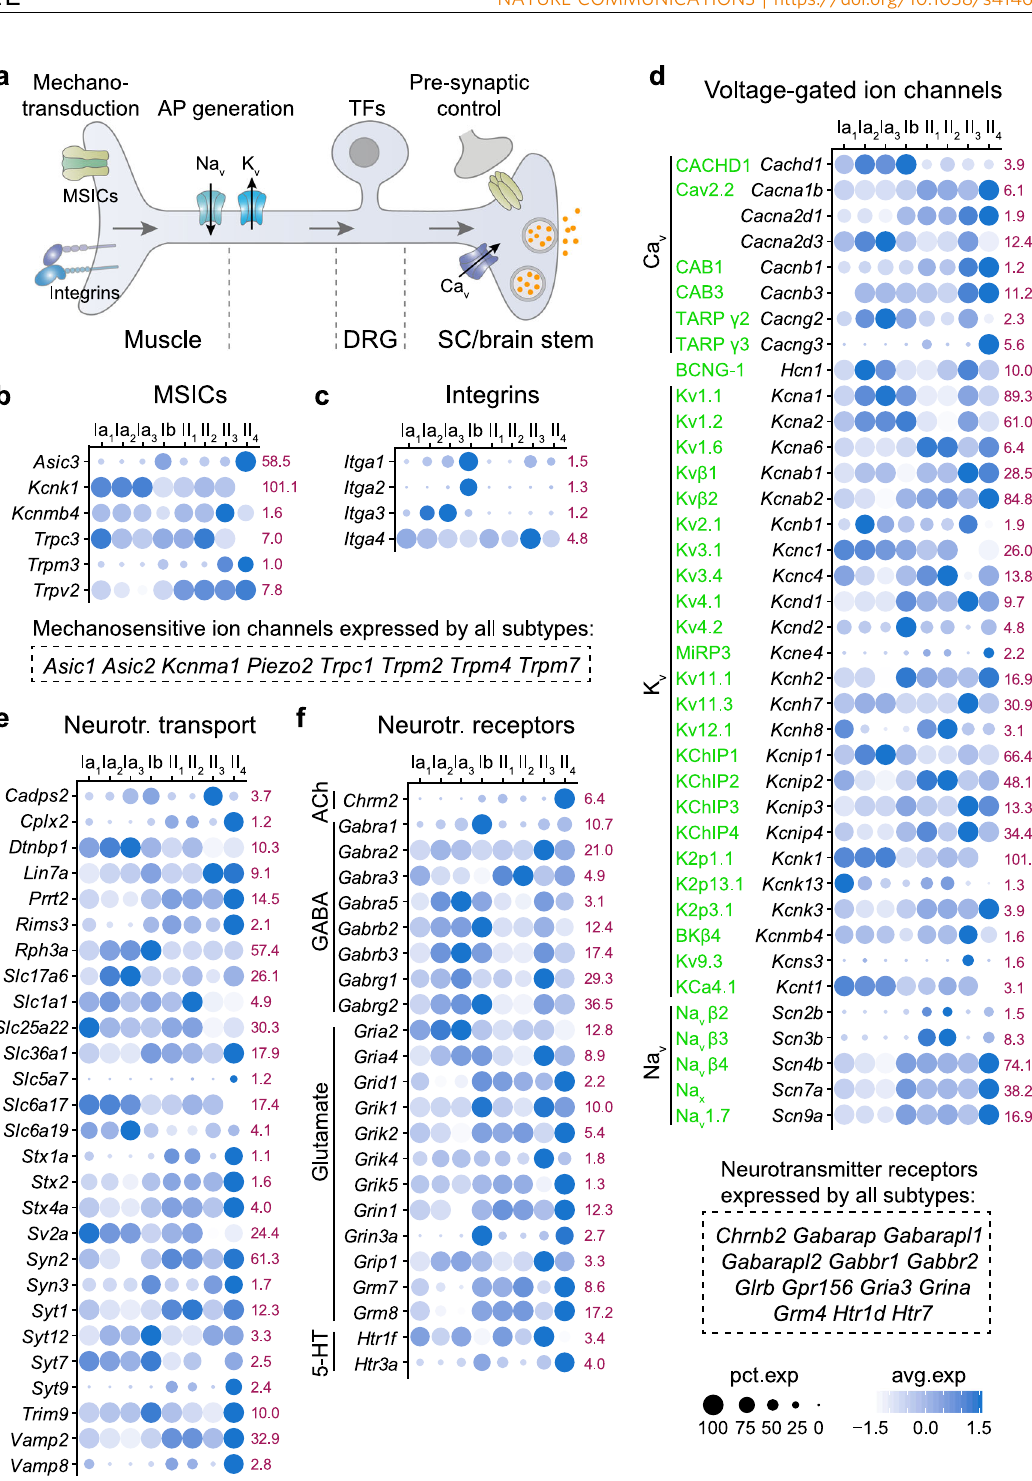
Fig. 4 Unique molecular signatures of neuronal communication pattern in the PN subtypes. a Schematic depicting gene categories important for intrinsic electrical properties and input-output communication patterns of PNs. b – f Dot plots of differentially expressed genes for functional neuronal properties, including “ mechanosensitive ion channels (MSICs) ” , “ integrins ” , “ voltage-gated ion channels (VGICs) ” , “ neurotransmitter transport ” and “ neurotransmitter receptors ” . The highest mean of expression among the subtypes is speci fi ed in red. Protein names for VGICs are shown in